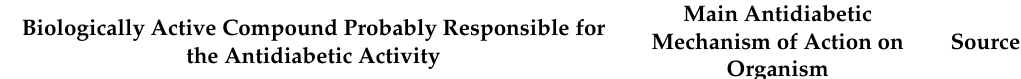
Trigonella foenum-graecum L.